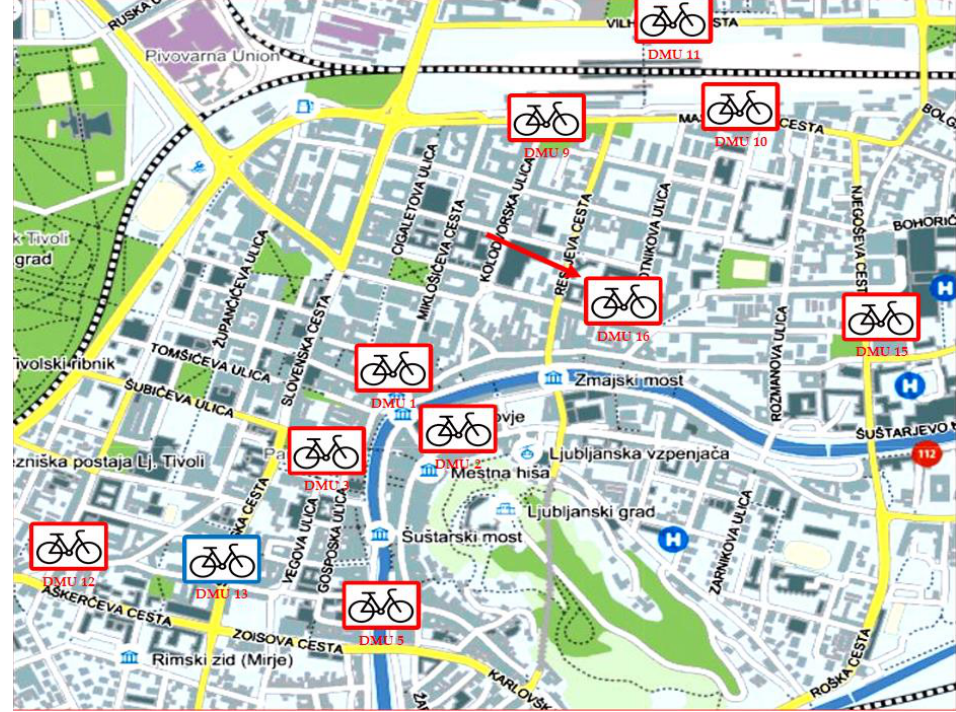
Figure 3. Optimal DMUs in the city centre cell of Ljubljana